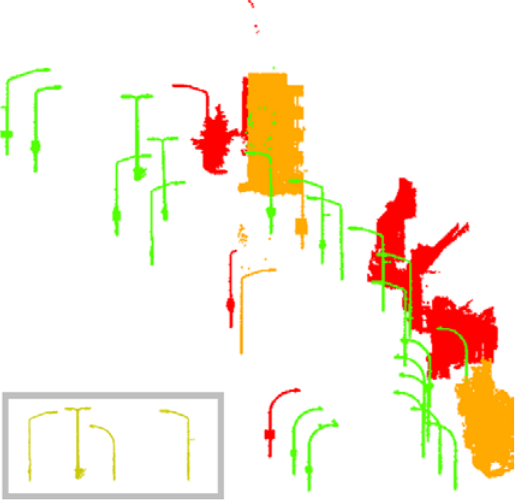
Figure 9 Correlation results on four lamp post samples (inset). Components are coloured by correlation: >0.9 (green), >0.85 (orange) and <0.85 (red). Components with correlation lower than 0.8 are not shown.